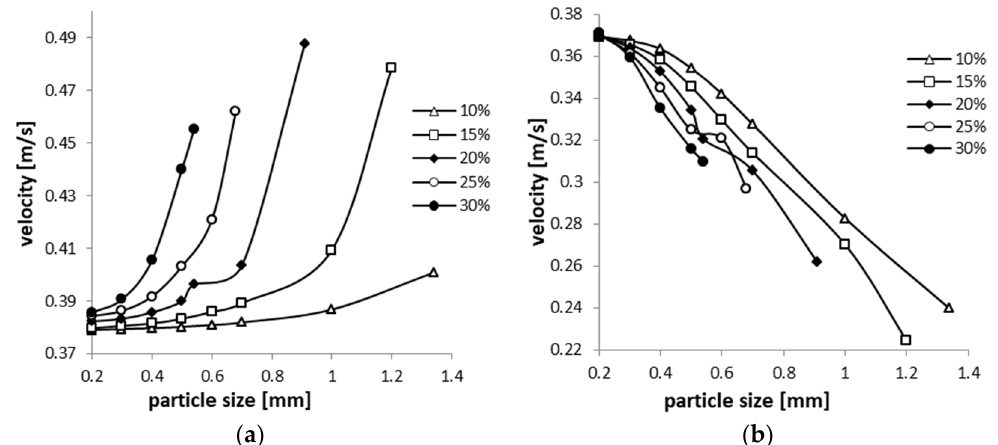
Figure 14. Liquid ( a ) and solid ( b ) phase velocity, depending on the solid particles size for different solid volume fractions at 140 kPa.